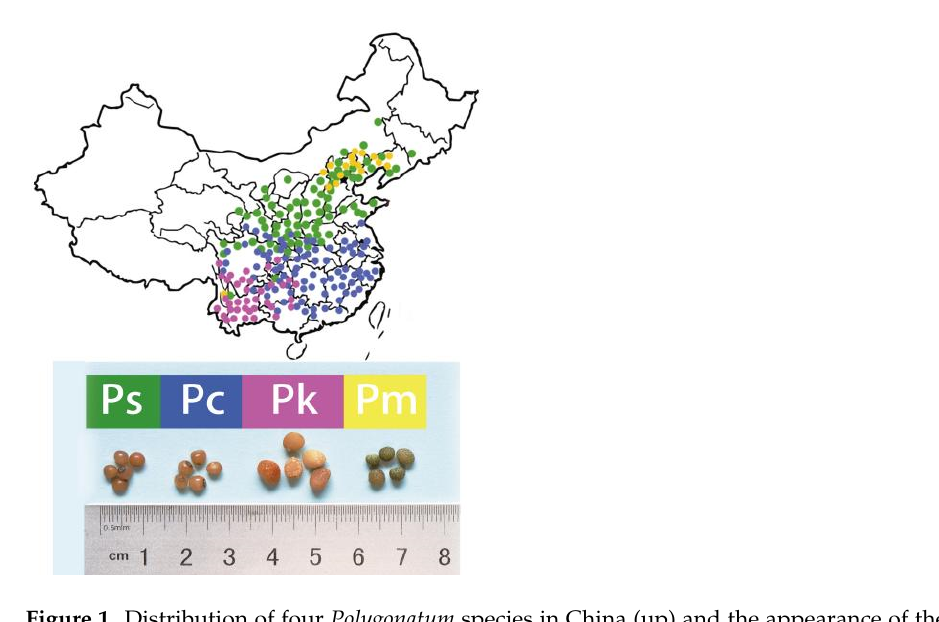
Figure 1. Distribution of four Polygonatum species in China (up) and the appearance of the seeds from the examined plants (down). Ps, Polygonatum sibiricum ; Pc, P. cyrtonema ; Pk, P. kingianum ; Pm, P. macropodium .